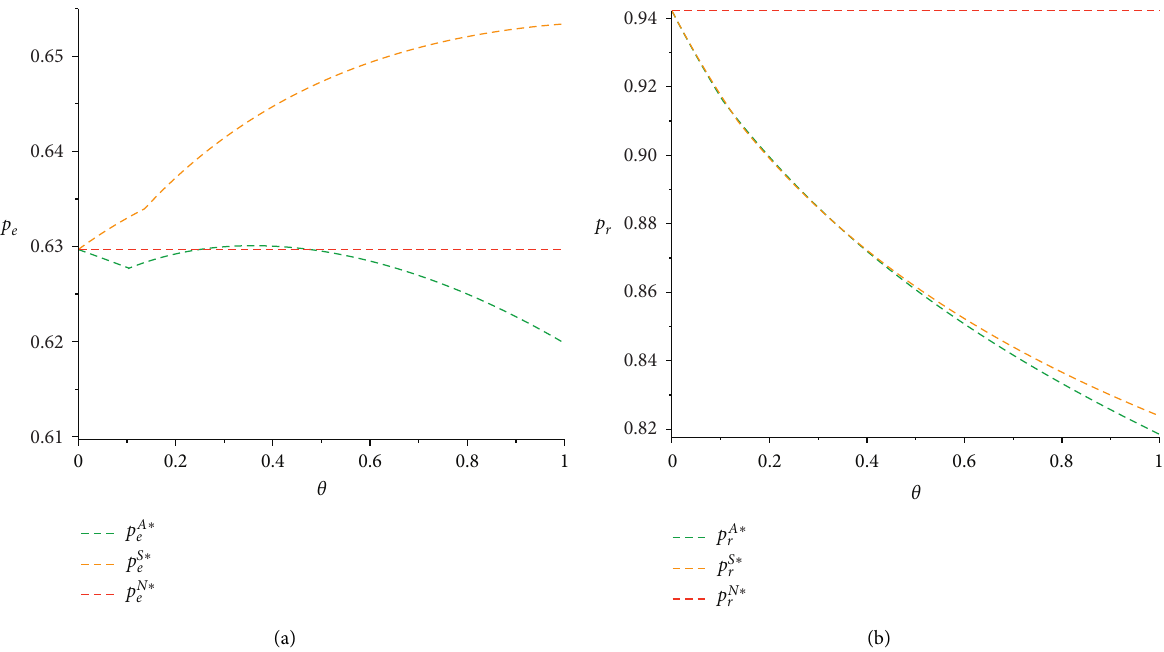
Figure 3: Comparison results of prices versus parameter θ when a � 0 . 25, b � 0 . 2, and c � 0 . 8. (a) Equilibrium prices of e-tail channel under three models. (b) Equilibrium prices of regular channel under three models.